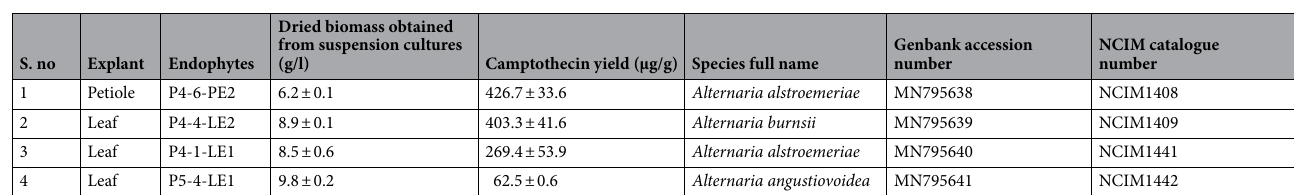
Table 2. Highest yielding endophytes with their camptothecin yield, accession and deposition